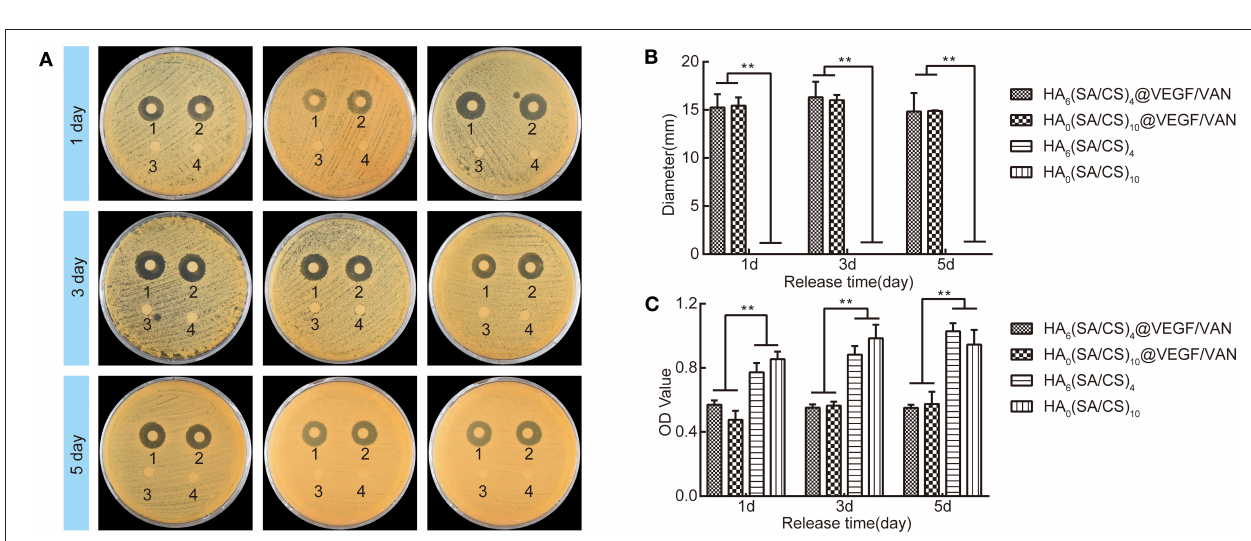
FIGURE 6 | (A) Bacterial growth inhibition on agar plates after 1d, 3d, and 5d. (B) The diameter of bacteriostatic rings of the four groups of scaffolds cultured for 1d, 3d, and 5d. (C) The OD value of the bacterial liquid medium after the scaffold and the bacterial liquid medium were co-cultured for 1d, 3d, and 5d. Numbers 1–4 indicate HA 0 (SA/CS) 10 @VEGF/VAN scaffold, HA 6 (SA/CS) 4 @VEGF/VAN scaffold, HA 0 (SA/CS) 10 scaffold, and HA 6 (SA/CS) 4 scaffold. ** p < 0.01.